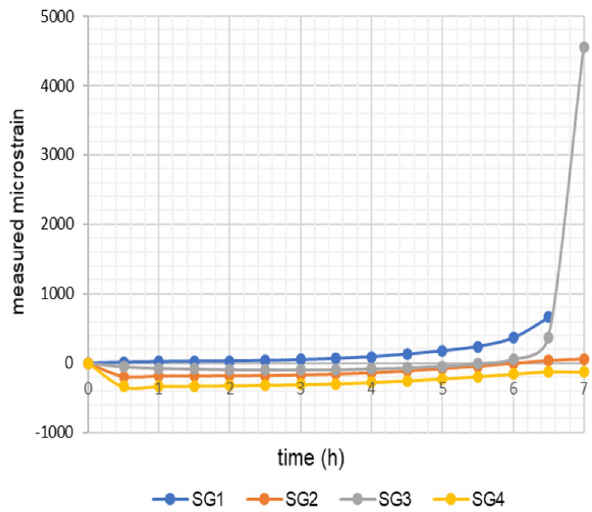
Fig. 22 Measured strains in specimen G-SL2-175-700-LT-L